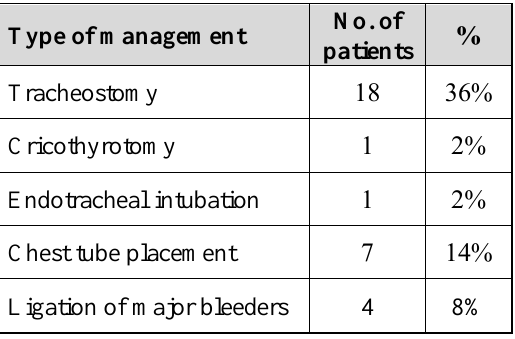
Table 1: Immediate resuscitating measures